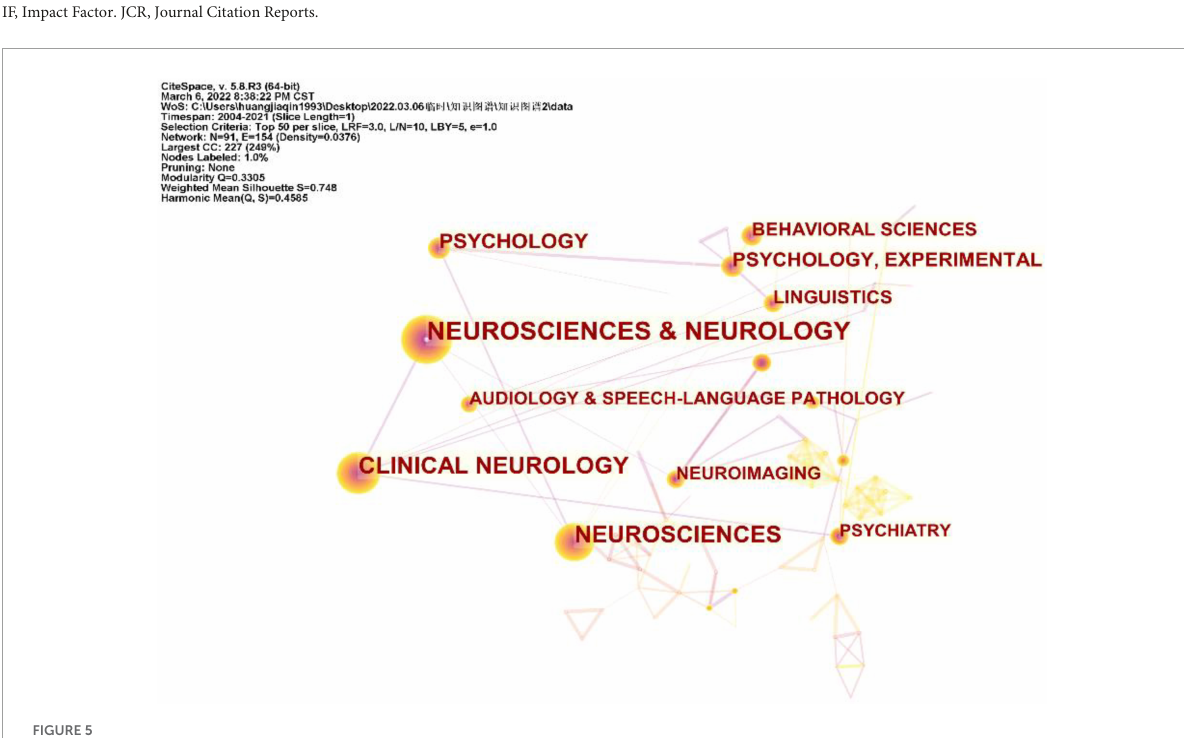
of the centrality analysis, especially UCL and University of California San